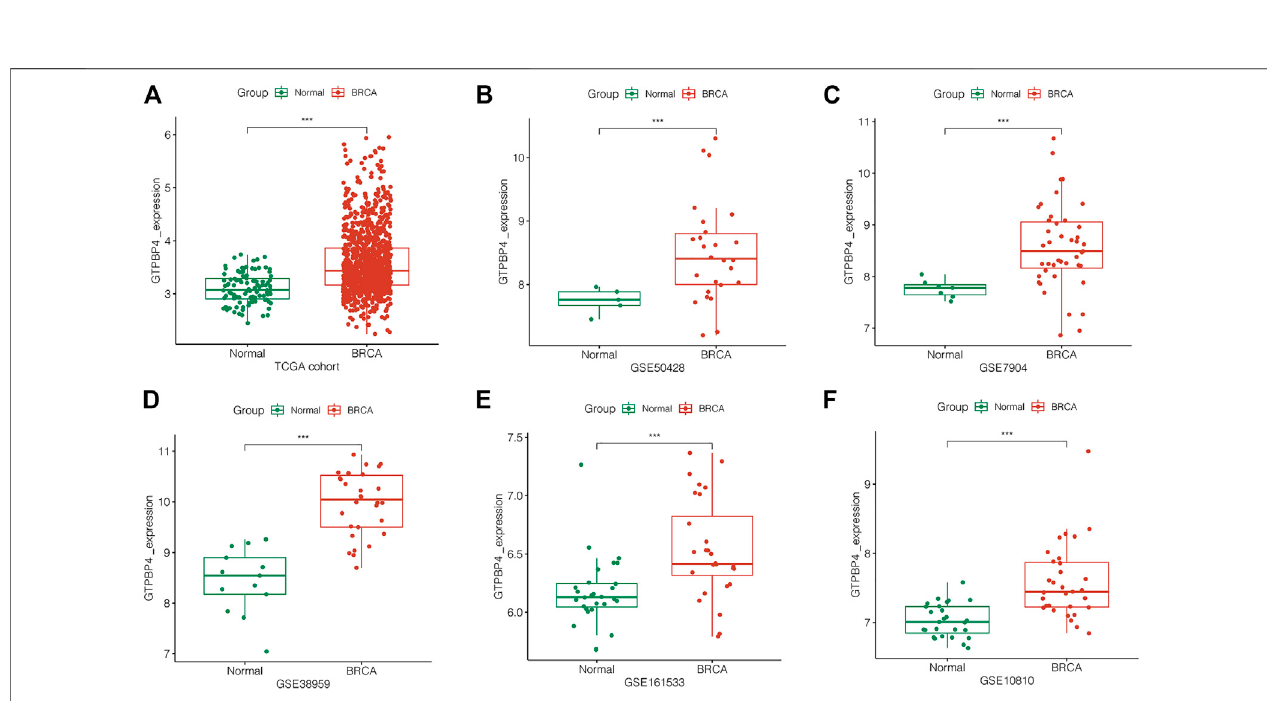
FIGURE 3 | Analysis of GTPBP4 expression in TCGA and GEO cohorts. In each cohort, compared with normal tissue, GTPBP4 expression in breast cancer were signi fi cantly upregulated (***p < 0.001). (A) TCGA cohort. (B) GSE50428. (C) GSE7904. (D) GSE38959. (E) GSE161533. (F) GSE10810.